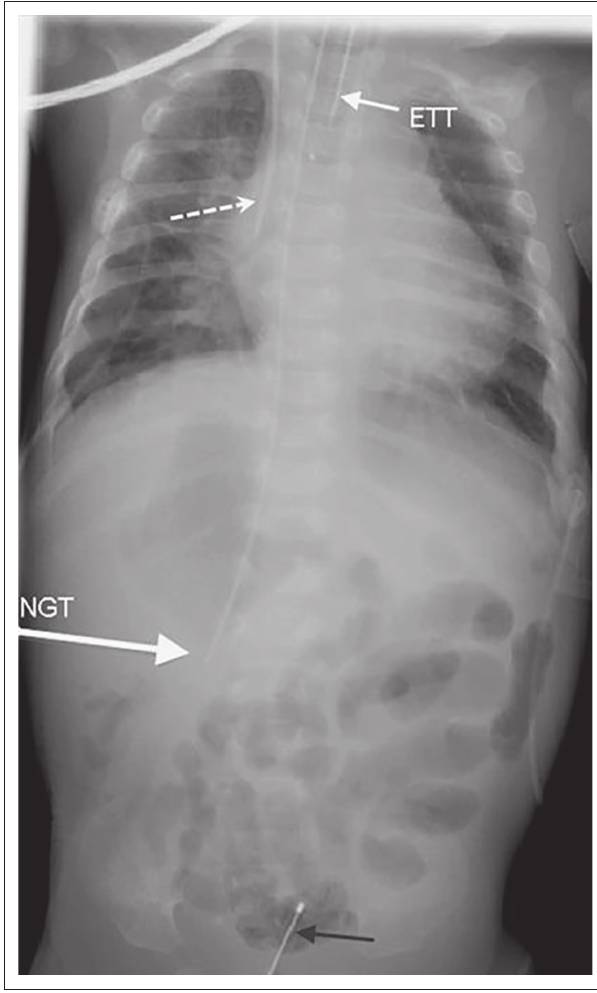
FIGURE 11: The nasogastric tube (NGT) end is within a right-sided stomach in a patient with abdominal situs inversus. There is a right-sided central venous catheter in situ with its end in the superior vena cava (SVC) (dotted arrow). A urinary catheter is in the bladder (black arrow).